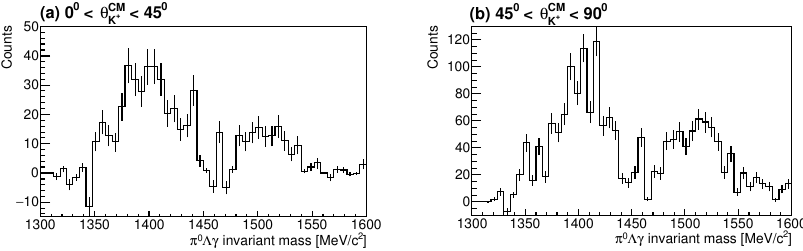
Figure 8. Very preliminary invariant mass distributions in the pure isospin I = 0 channel π 0 Σ 0 → π 0 Λ γ in the mass range of the Λ (1405), split into two angular regions of forward going K + in the reaction γ p → K + X